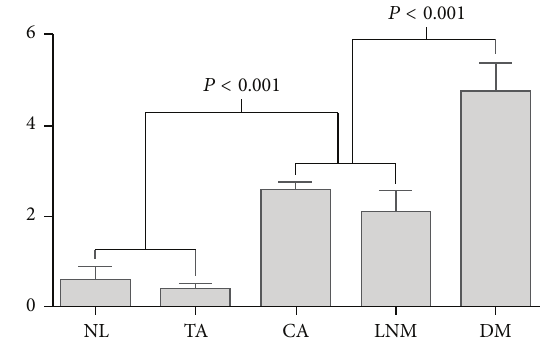
Figure 2: Mean DUSP4 expression score in normal colorectal tissue (NL), tubular adenoma (TA), adenocarcinoma (CA), lymph node metastasis (LNM), and distant metastasis (DM).